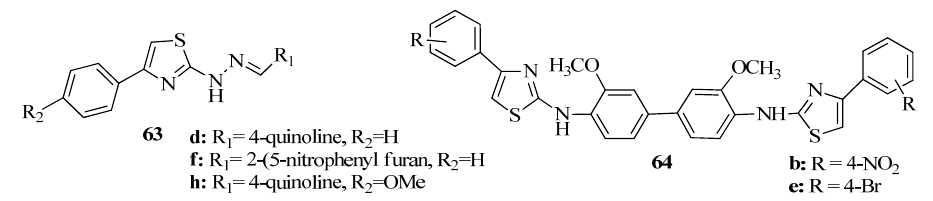
Figure 25. Structures of hydrazinil and bis-thiazole derivatives.